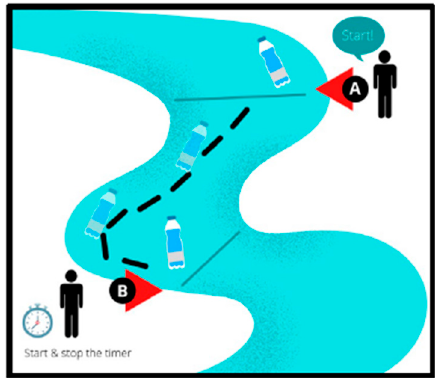
Figure 5. Time of Travel (ToT) Method. Point A is the starting point for FL being tossed and the timer starts. Point B is where the timer stops when FL passed the point. Source: Author.